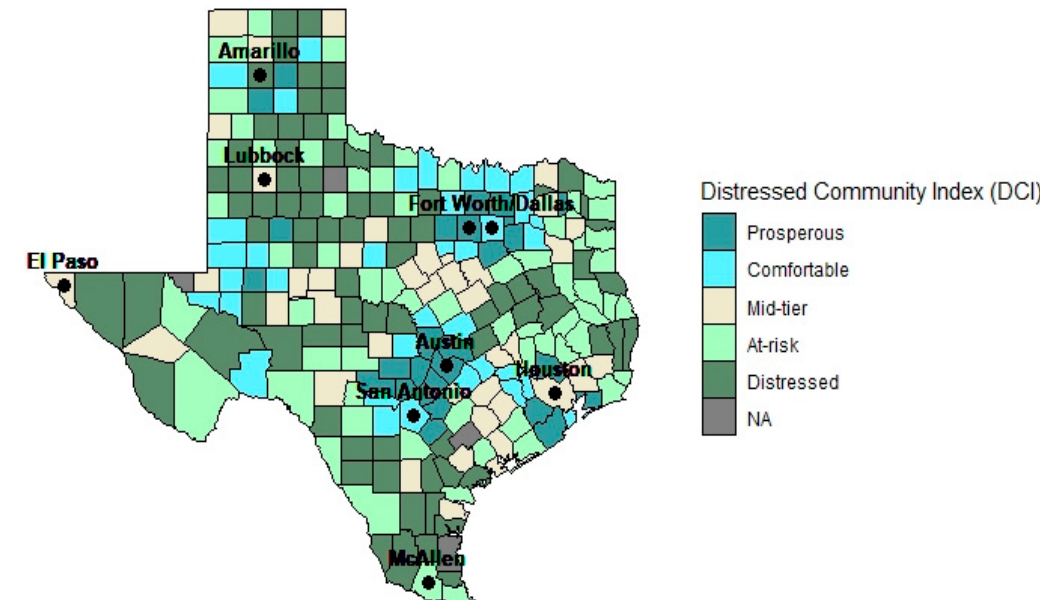
Figure 1. Distribution of Texas counties, by distressed community index. The Distressed Community Index measures economic well-being and inequality. It combines seven distinct and complementary socioeconomic indicators, measured at the county level, to create a single score. The score is used to sort each county into quintiles that depict how the economic well-being in the county compares to other areas: prosperous, comfortable, mid-tier, at risk and distressed.